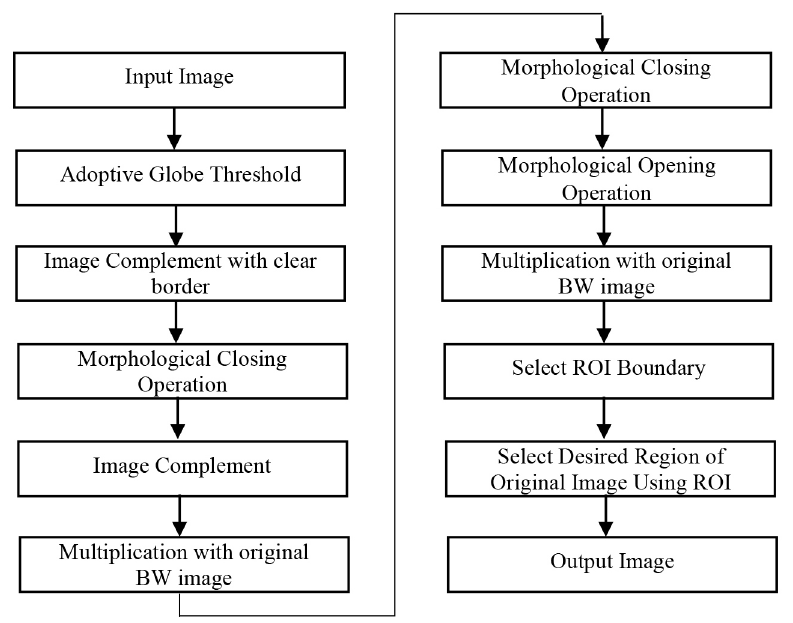
Figure 1. Flowchart of the proposed segmentation